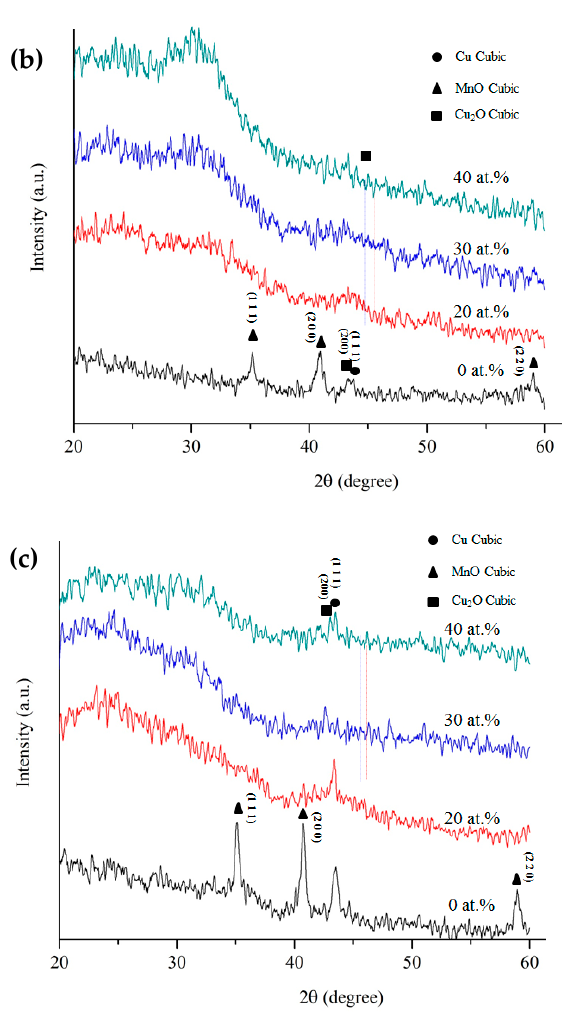
Figure 1. X-ray diffraction patterns of Cu–Mn–Dy thin films with various amounts of dysprosium addition annealed at ( a ) 300 ° C; ( b ) 350 ° C; and ( c ) 450 ° C.